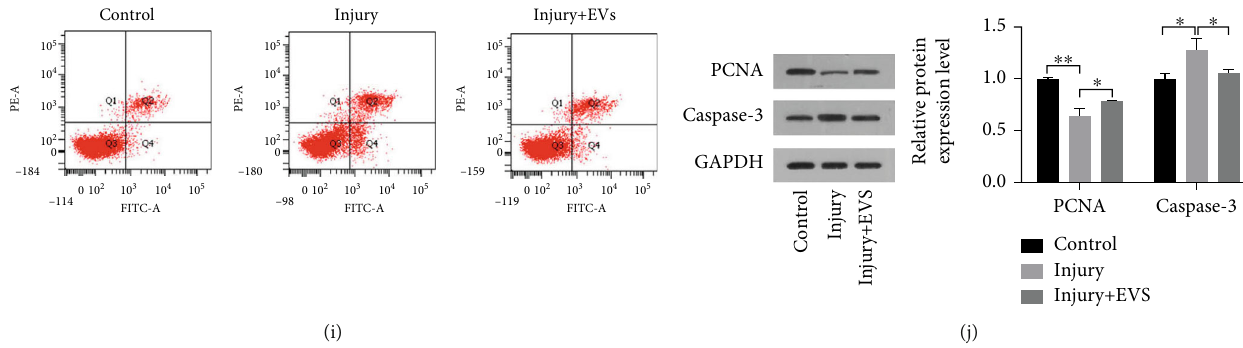
Figure 3: ADSC-derived EVs inhibited oxidative stress and promoted proliferation of tendon cells. (a) TEM was used to observe the structure of EVs (scale: 100 nm). (b) DLS was used to observe the particle size of EVs. (c) Western blot was used to detect the markers of EVs. (d – g) ELISA was used to detect the levels of CK, LDH, MDA, and SOD in the control group, injury group, and injury+EVs group. (h) MTT was used to detect the activity of tendon cells. (i) FCM for the detection of the apoptosis of tendon cells. (j) The expression of apoptosis-related proteins was detected by Western blot ( ∗ P < 0 : 05 , ∗∗ P < 0 : 01 , and ∗∗∗ P < 0 : 001